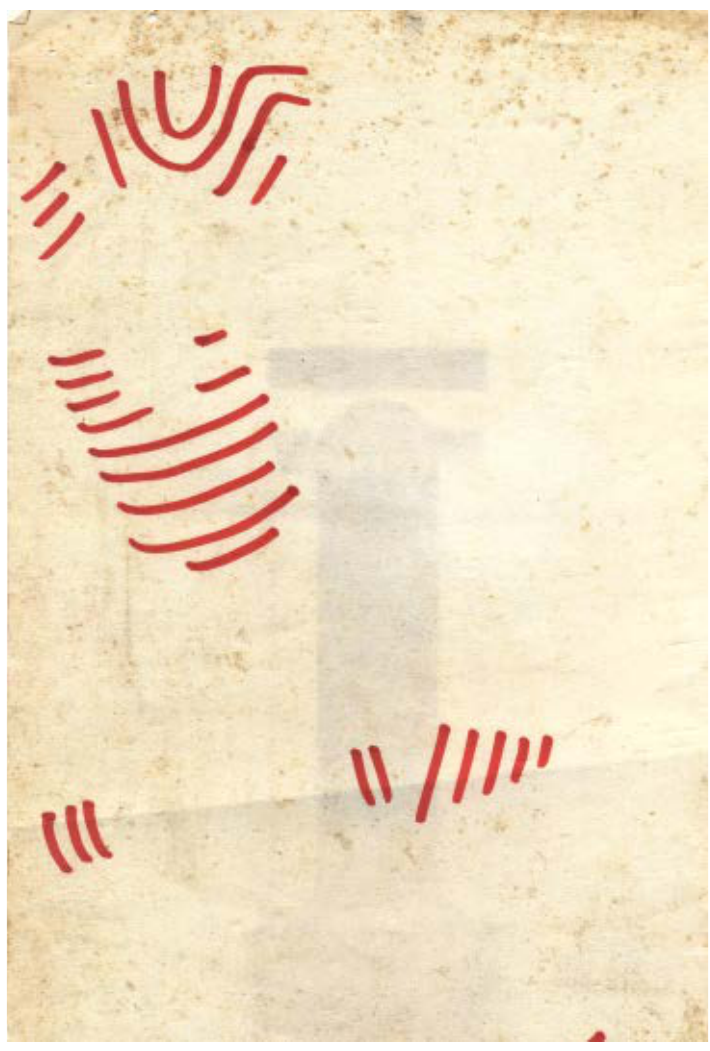
Figure 5. Images from Tidrit (drawing